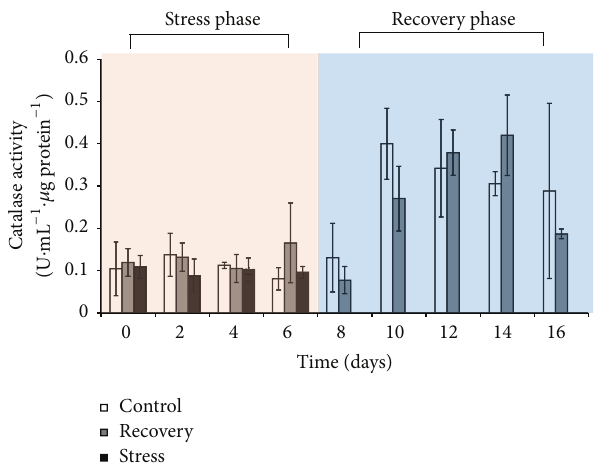
Figure 9: Catalase activities measured as hydrogen peroxide left- oversin Pocilloporadamicornis coralhostfractions( 𝑛 = 3 )incontrol (26 ∘ C); recovery treatment (ramping from 26 ∘ C at day 0 to 32 ∘ C at day 6 then cooling to 26 ∘ at day 9); and stress treatment (ramping from 26 ∘ C at day 0 to 32 ∘ C at day 6) during 16